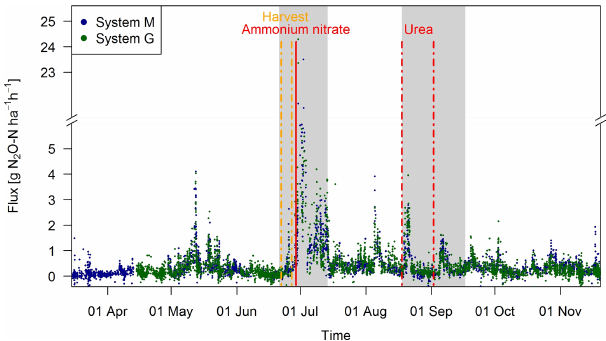
Figure 6. Time series of half-hourly EC flux measurements in both systems during the grazing season 2016. For the analysis of grazing- related emissions, only the non-shaded periods (GOP) were used. The vertical lines show the timings of fertilization (red) and harvest (orange) events. Dashed lines indicate that harvest and urea appli- cation were split for the western ( X .11– X .16) and eastern ( X .21– X .25) parts. The shaded areas indicating time periods influenced by fertilization events or harvest were excluded for the evaluation of grazing excreta-related emissions. One flux value (29.0gN 2 O- Nha − 1 h − 1 on system M, 30 June 2016) was skipped for better